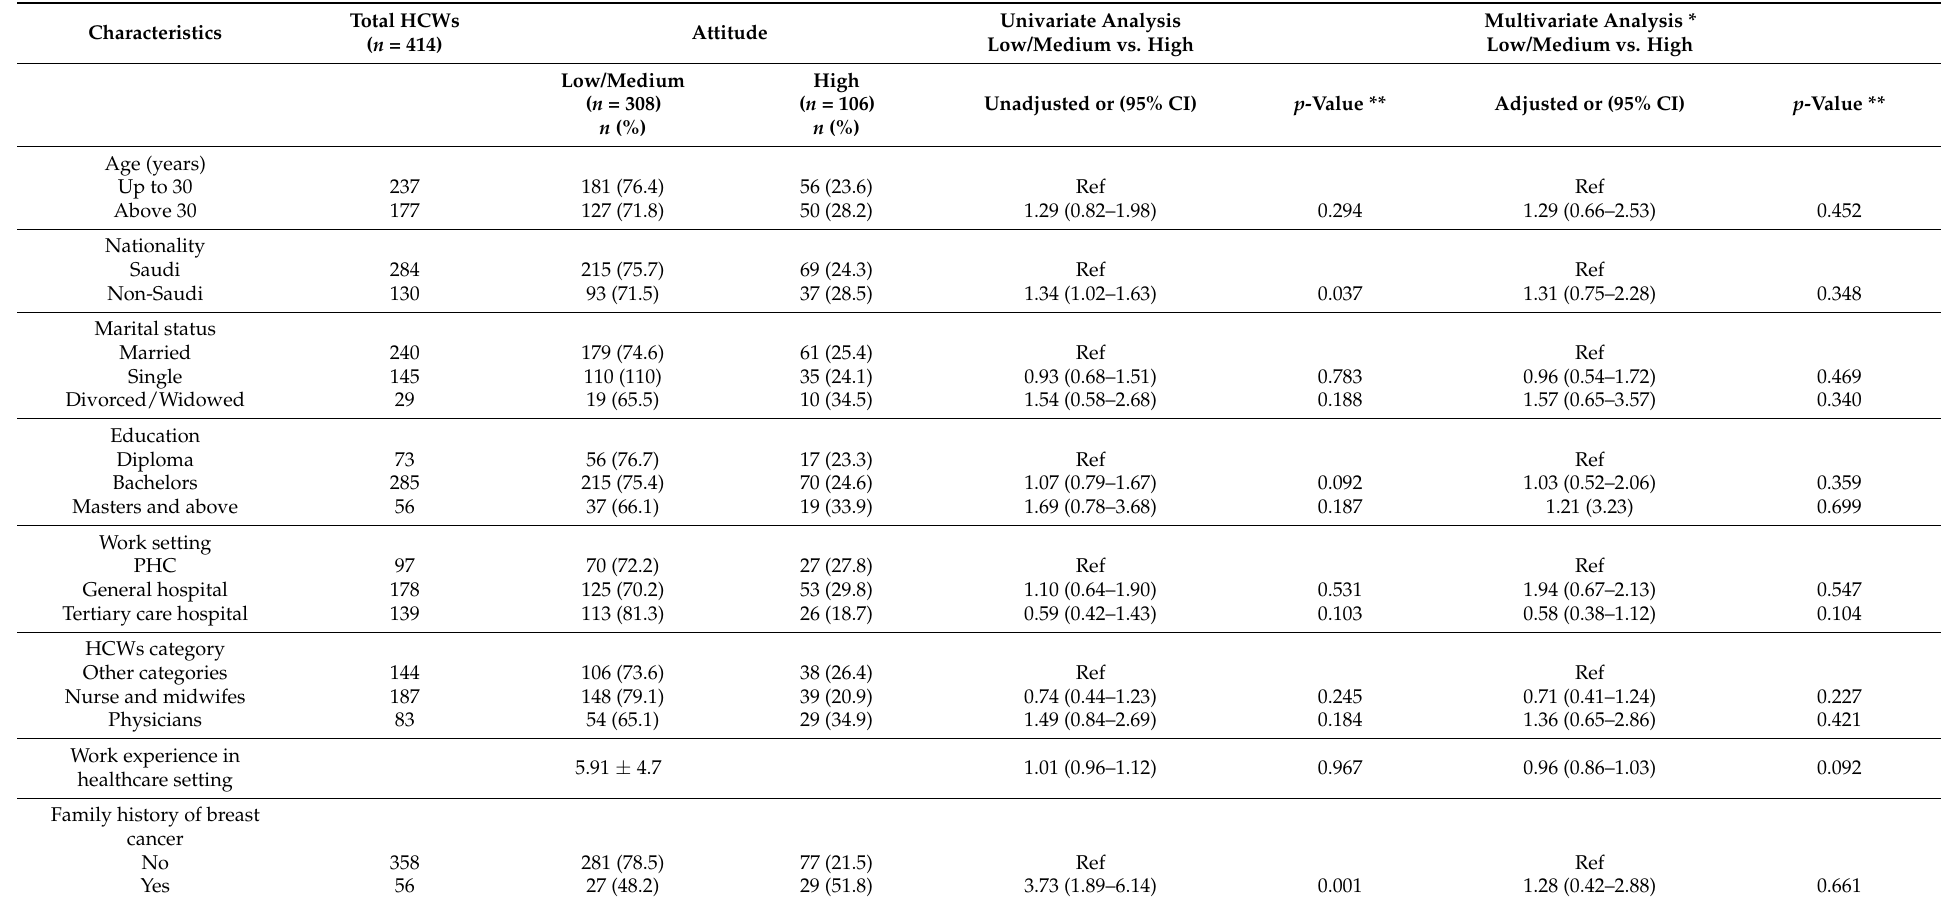
Table 5. Binomial regression analysis between participants’ socio-demographic characteristics and attitude towards breast cancer ( n =